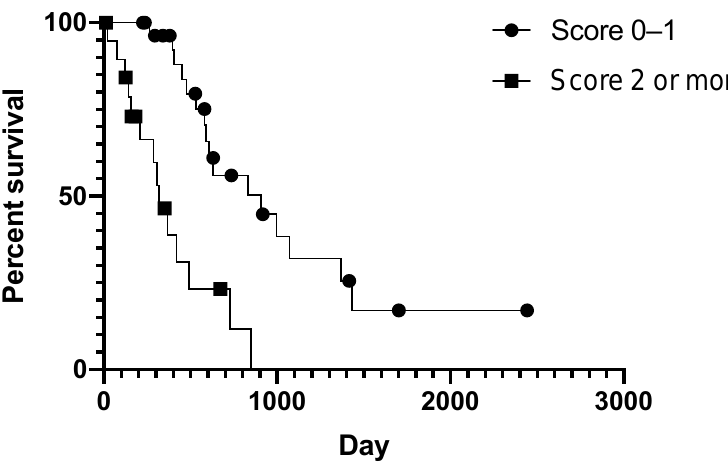
Figure 6. Histopathological algorithm can be used to group AGASAC patients with favourable or worse survival. Kaplan–Meier plot showing cases stratified by the histopathological grading system. Log-rank p = 0.0001. Symbols indicate censored cases.